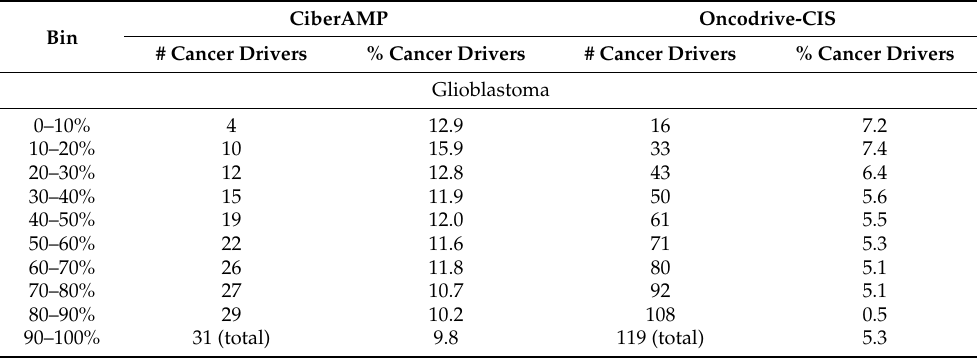
Table 2. CiberAMP benchmarking using indicated TCGA datasets. Please, note that the number of cancer drivers is progressively accumulated as we move from the 0–10% to the 90–100% bin. This latter bin contains all identified cancer drivers by each algorithm. In addition, note that the two algorithms use different criteria (e.g., overall impact on gene expression) to generate the list of SCNV-DEGs.